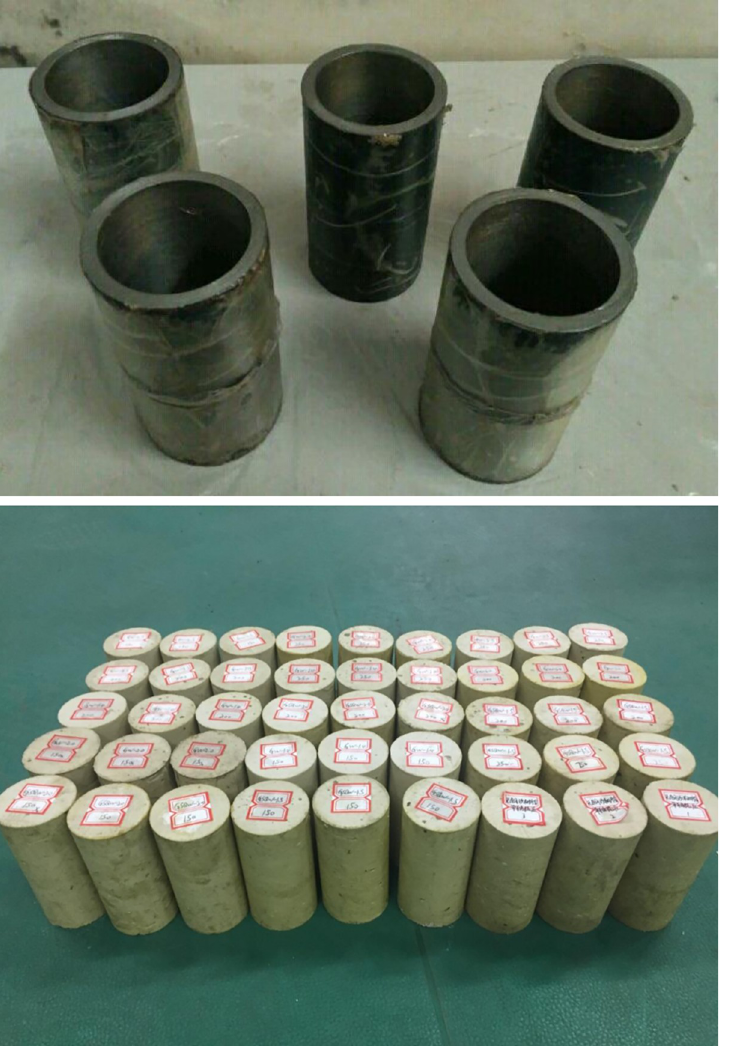
Fig 4. Compressive strength testing